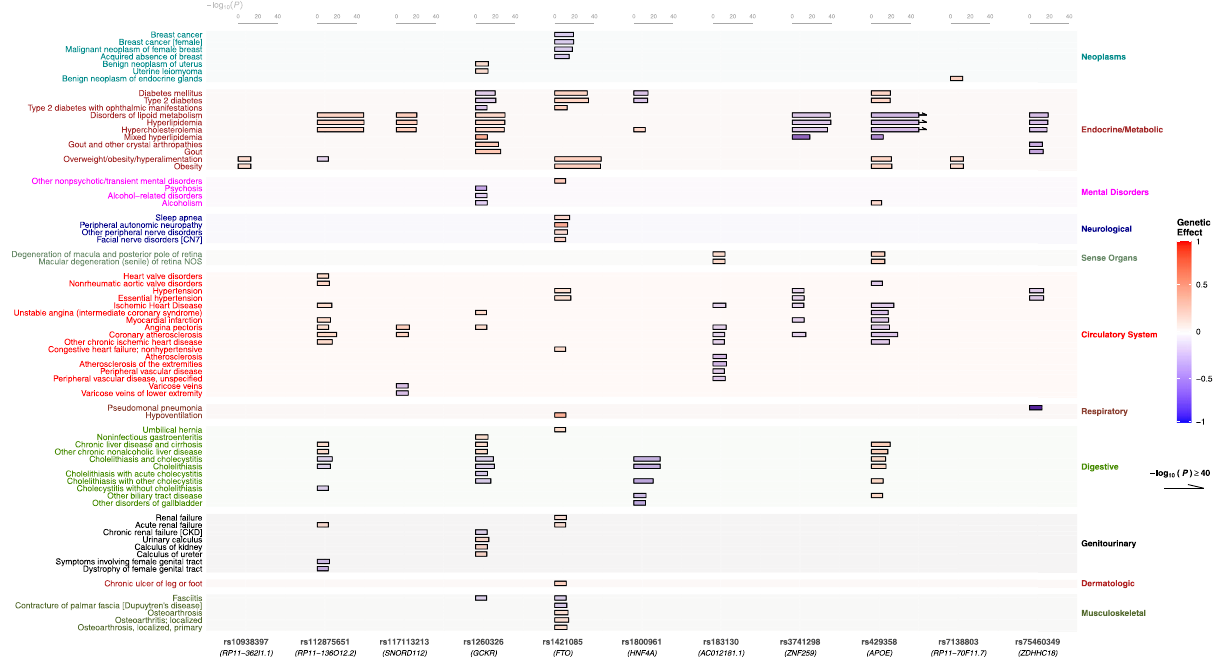
presented 96 FDR signi fi cant associations that can be found in Supplementary Data 13. To optimize the visualization of the results, the diseases that were asso- ciatedonly with thatvariant wereremoved from the graph. The variant rs11635675 ( USP3 ) presented no FDR signi fi cant association and thus it was removed from the graph. The exact summary statistics are provided in Supplementary Data 13.